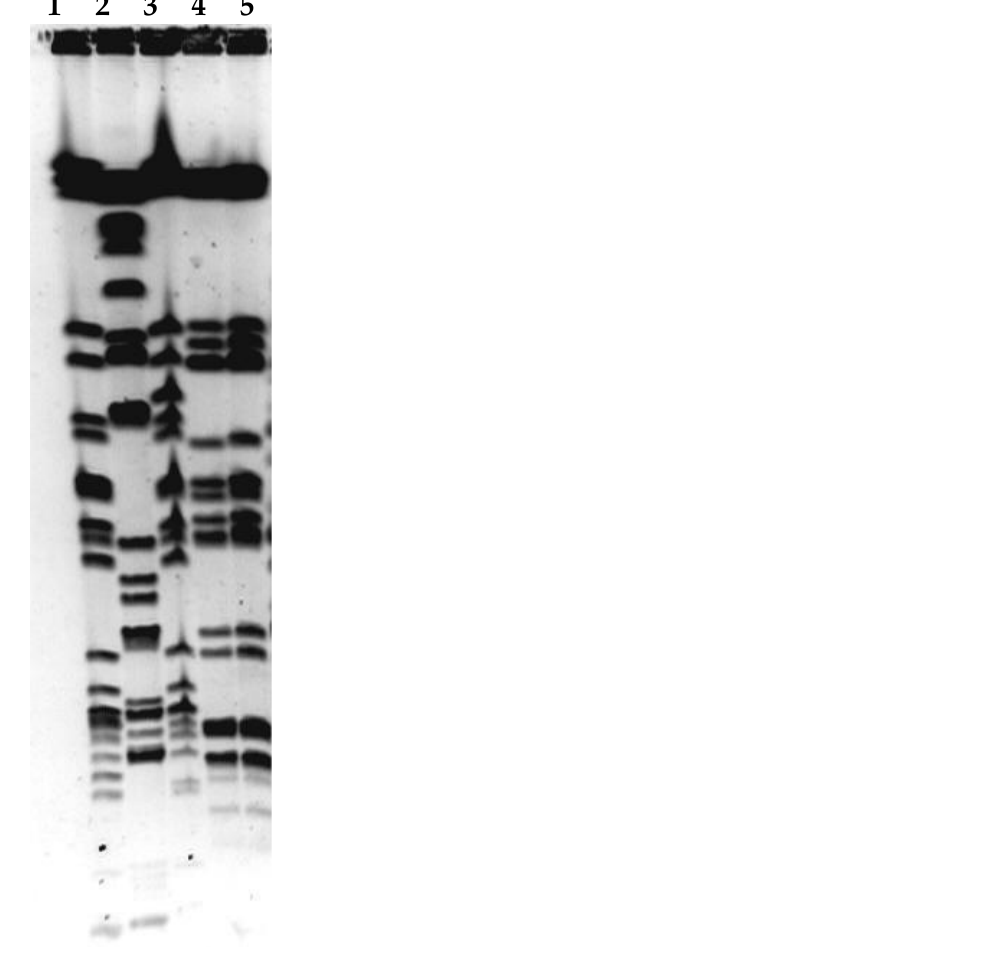
Figure 3. Pulsed-field gel electrophoresis of phage-sensitive isolates. Xba I macrorestriction pattern; ( 1 ) Ni9, ( 2 ) 2060, ( 3 ) 2179, ( 4 ) GN81, ( 5 ) GN 784.